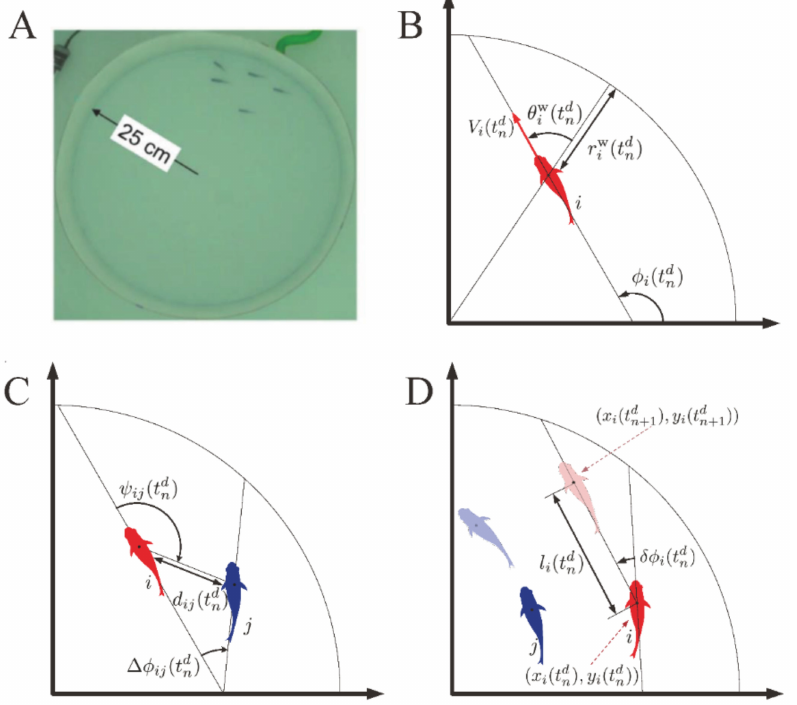
Figure 1. The configuration of a real fish experiment and parameters in the global reference systems at the decision time t d n ( A ) Five–fish schooling experiment in a tank which radius R W = 250 mm; ( B ) The position parameters of fish, where r W represents the radial distance from fish i to the wall. φ i i is the heading angle of fish i , V i is the speed of fish i , the direction of V i is determined by the φ i ; θ W i represents the relative angle from fish i to the wall; ( C ) The measurement parameters of neighbor fish (blue). d ij represents the relative distance between fish i and its neighbor j ; ψ ij represents the angle of fish i perceiving its neighbor j (note that ψ ji (cid:54) = ψ ij ); ∆ φ ij ( t ) = φ j ( t ) − φ i ( t ) represents the difference of heading angle between fish i and its neighbor j ; ( D ) The moving decision parameters of the focal fish (red). δφ i ( t d n ) is the change of heading angle of fish i at the decision time t d n , l i ( t d n ) is the one kick distance between t d n and t d n + 1